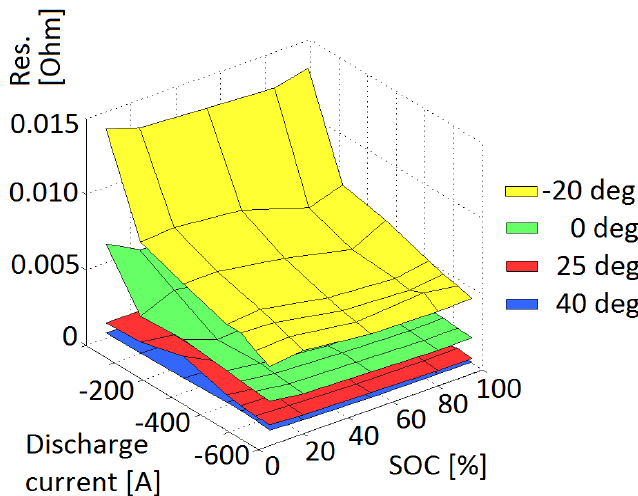
Figure 5. Internal resistance for a 30-A·h lithium nickel-manganese-cobalt oxide (NMC) cell as a function of temperature and SOC for various